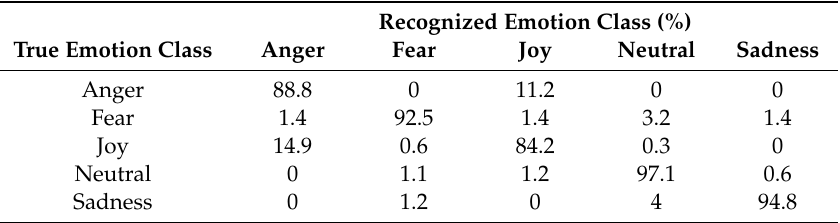
Table 1. Normalized confusion matrix for linear Bayes